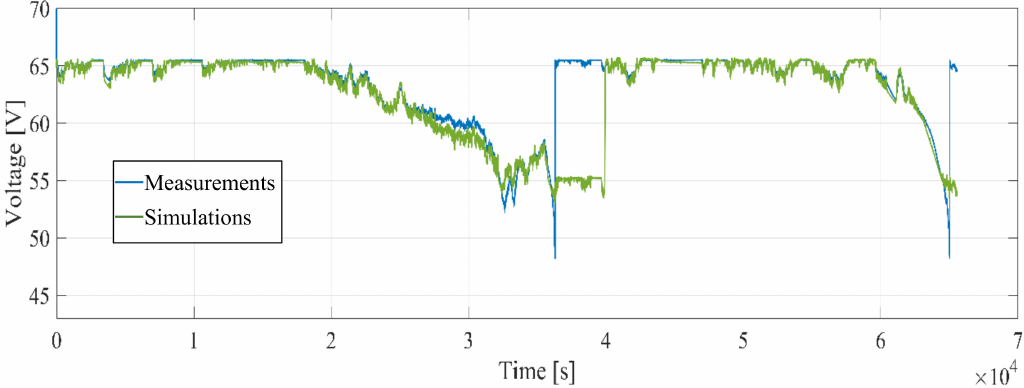
Figure 7. Comparison between measurements and model results for the 260th and 261th aging